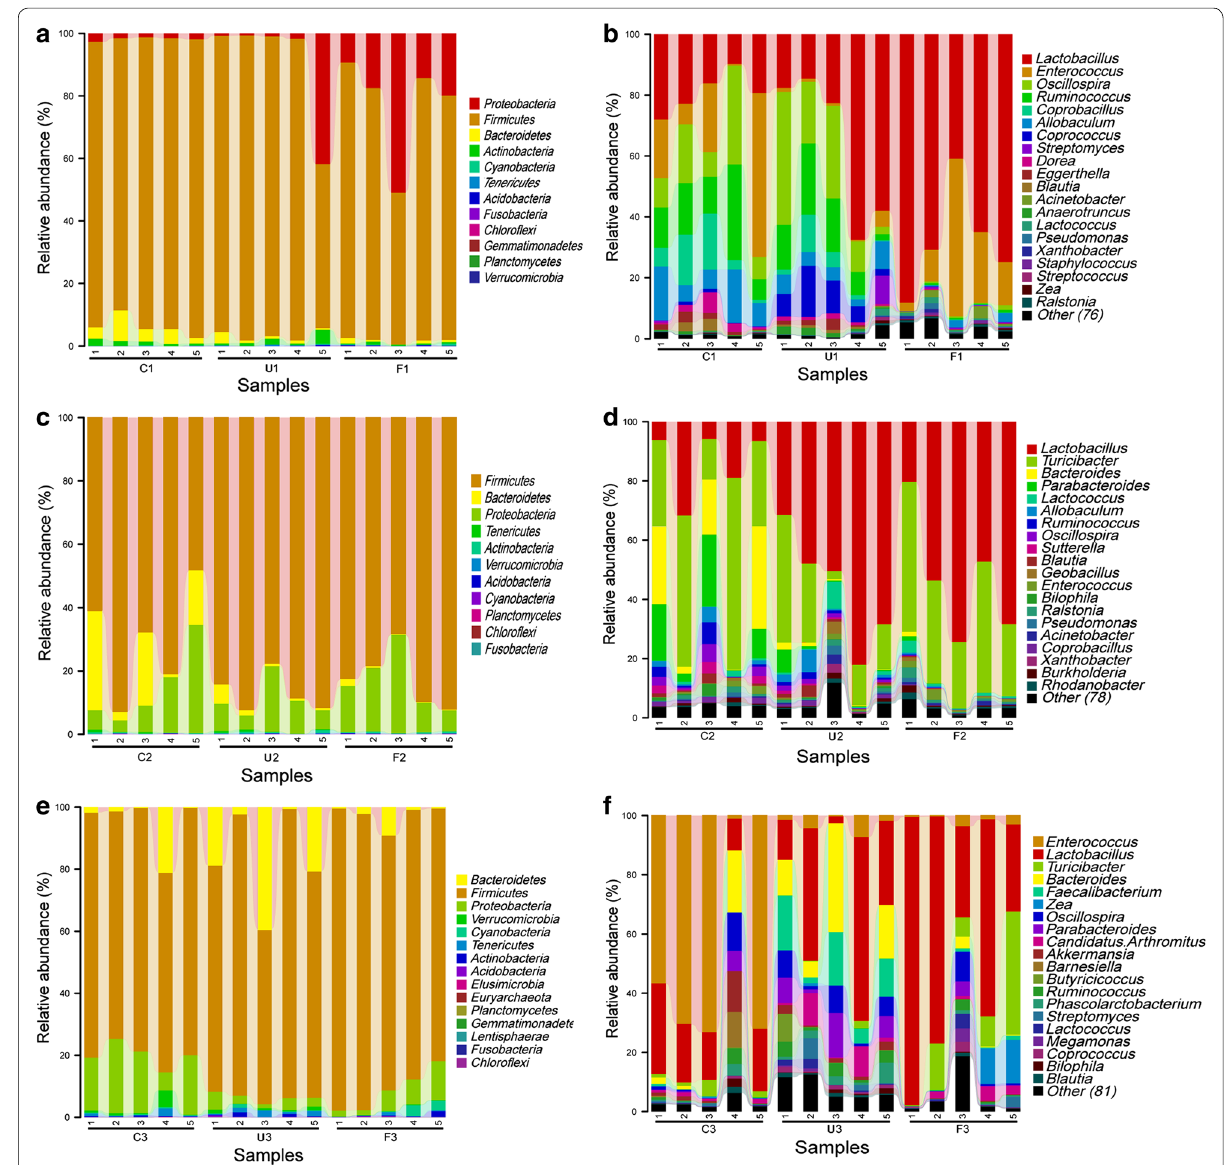
Fig. 2 Phylum- and genus-level analysis of the 45 samples. a Overall fecal microbiota composition of samples at the phylum level on day 7. b Overall fecal microbiota composition of samples at the genus level on day 7. c Overall fecal microbiota composition of samples at the phylum level on day 21. d Overall fecal microbiota composition of samples at the genus level on day 21. e Overall fecal microbiota composition of samples at the phylum level on day 35. f Overall fecal microbiota composition of samples at the genus level on day